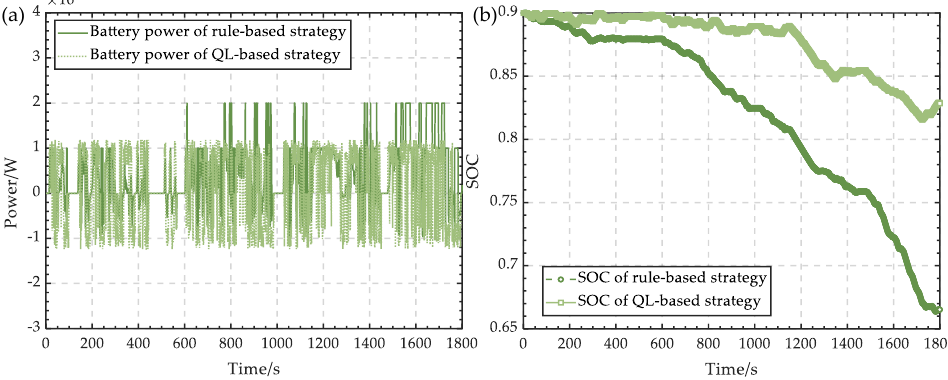
Figure 7. ( a ) Comparison of the output power between the rule- and QL-based strategies. ( b ) Com- parison of the SOC trajectory between the rule- and QL-based strategies.